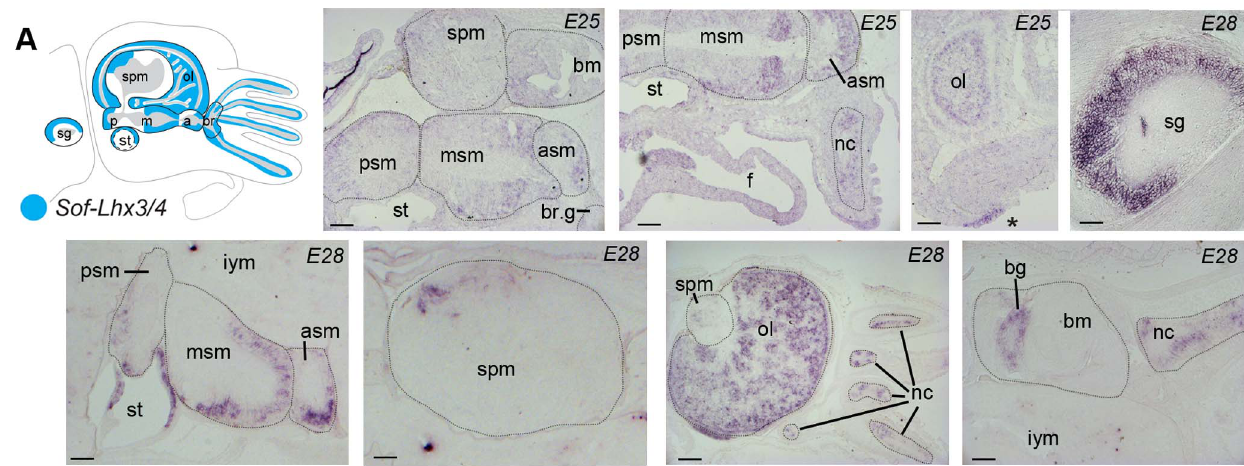
Figure 5. Spatial gene expression profiles of Sof-Lhx3/4 . Figure layout as in Figure 4. Clockwise from upper left: Medial section through the head detecting moderate expression levels within all lobes of the CNS and the posterior mesenchyme of the buccal mass; A more lateral section of the same embryo, highlighting the strong expression domain within the middle and anterior subesophageal masses, and expression within the nerve cords of the arms; Lateral section showing expression within the optic lobes and the presumptive olfactory pit epithelium (*); Expression within the stellate ganglion is absent in the ventral-anterior most portion; Medial section at the level of the buccal mass showing expression within the buccal ganglion and neural cord of the arms; Section at the level of the optic lobes demonstrating expression throughout. Expression is also evident in the nerve cords of the arms but absent in the dorsal-lateral portion of the supraesophageal mass; Medial section through the supraesophageal mass showing expression domain in the dorsal-anterior most portion; Medial section through the subesophageal mass illustrating expression domains within the anterior-most portion of the anterior and middle masses, as well as the posterior-most portion of the posterior mass and underlying statocyst. Abbreviations: bg: buccal ganglia; nc: nerve cord; all others as in Figures 3 and